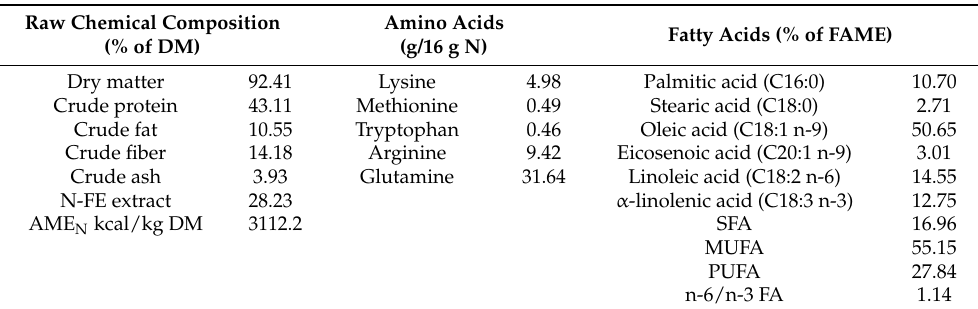
Table 2. Chemical composition, major amino acids and fatty acids of white lupine from low-alkloid varieties (cv.